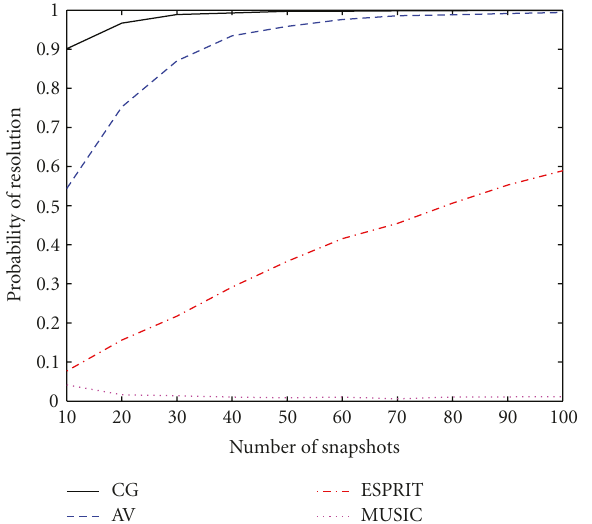
Figure 3: Probability of resolution versus number of snapshots (separation 3 ◦ , SNR = 0dB).